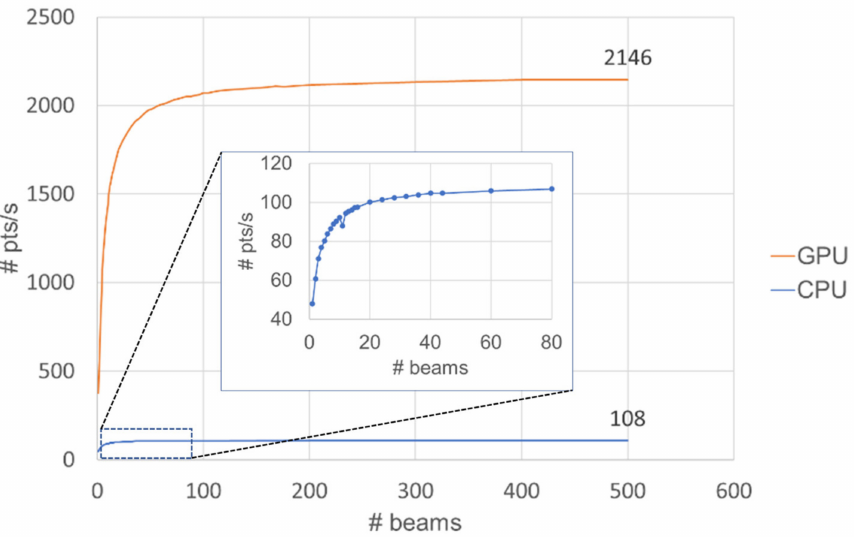
Figure 13. Effective beam-steering speed (RGB mode) on a GPU and a CPU. X -axis represents the number of points/CGH for beam steering; Y -axis represent the effective beam-steering speed. The inset shows the calculation speed of the CPU-based approach for the # of beams/CGH up to 80. Currently, we have demonstrated that GPU (GTX 1650-ti, Nvidia)-based TI-PLM single- beam steering and multi-beam steering (number of beams < 6) with a speed of 180 FPS are limited by the frame rate of the current generation of the TI-PLM. When the beam-steering speed needs to be faster, three aspects can be considered. Using the higher-performing GPU increases the calculation speed of CGHs significantly. For example, the Nvidia RTX 3080 GPU (clock speed of 1440 MHz, floating-point performance of 29.77 TFLOPS, texture rate of 465.1 GTexels/s, effective memory clock speed of 19,000 MHz, memory bandwidth of 760 GB/s, 10 GB of VRAM, and 320 bits memory bus width) can perform at least 4-fold faster than the GTX